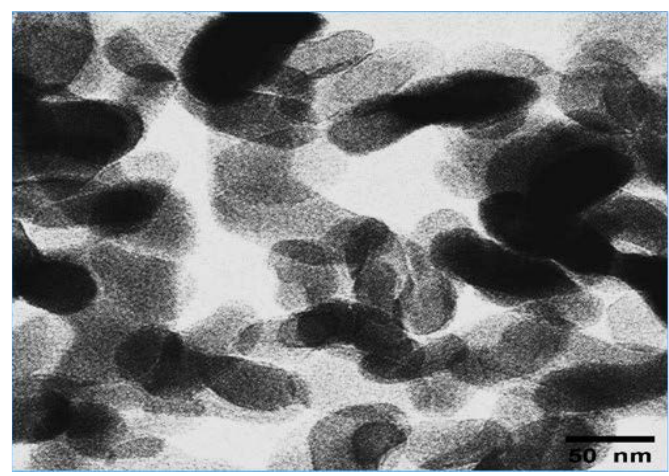
Figure 6. HRTEM micrograph of MgAl 2 O 4 NPs.